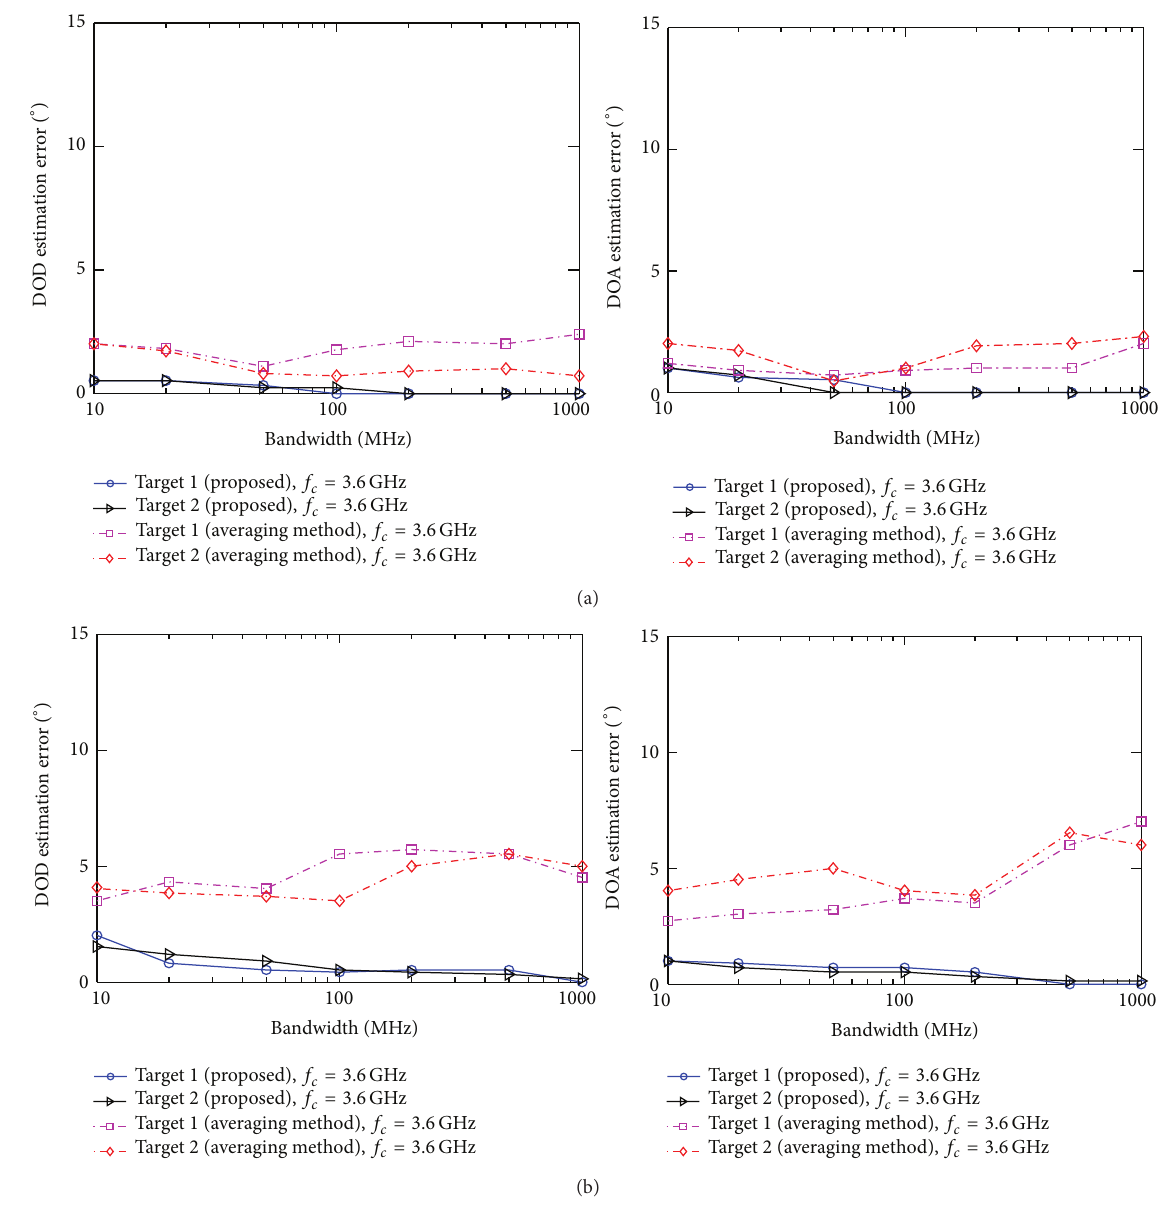
Figure 13: Estimation errors against bandwidth: (a) fixed point and (b) Weibull